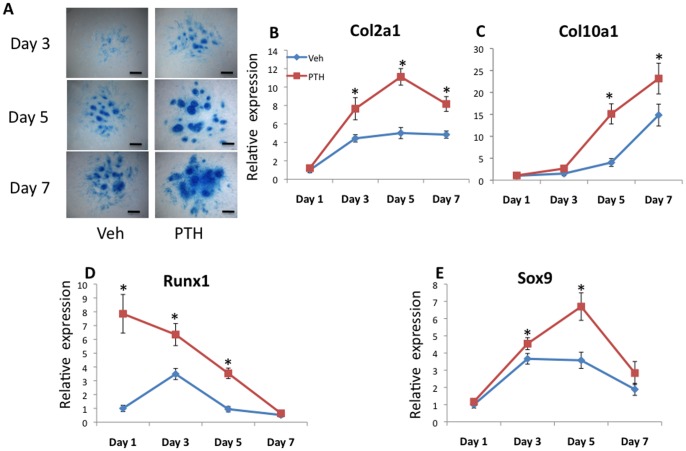
PTH promotes chondrogenesis in limb bud cell micromass culture.Limb bud cells were cultured in micromass and treated intermittently with 10−8M PTH 1–34 before being harvested for Alcian blue staining and RT-PCR analysis. (A) PTH treatment resulted in increased cartilage nodule formation at days 3, 5, and 7, compared to vehicle-treated controls. Scale bars, 100 µm. (B, C, D and E) PTH treatment increased Col2α1 expression at days 3, 5, and 7, with maximal increase at day 5. Col10a1 expression was increased at days 5 and 7. Runx1 expression was significantly increased by PTH at days 1, 3 and 5 with maximal increase seen at day 1. Sox9 levels were increased at days 3 and 5. Data are means ± SD of three independent experiments performed in duplicate and the control gene expression level at day 3 was set at 1. (*p<0.05 compared with control at same time point).